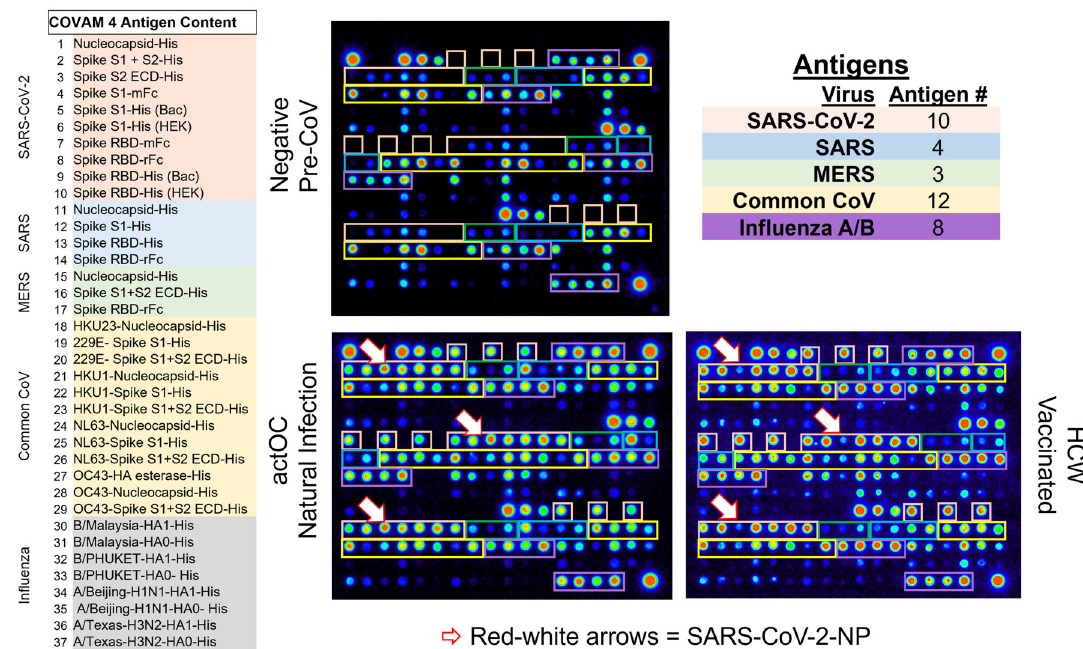
Fig. 1 Coronavirus antigen microarray — COVAM. The content of the coronavirus antigen microarray is shown. There are 10 SARS-CoV-2 antigens, 3 SARS, 3 MERS, 12 Common COV, and 8 in fl uenza antigens. Each antigen is printed in triplicate and organized as shown on the images with Orange boxes around the SARS-CoV-2 antigens, Blue SARS, Green MERS, Yellow Common CoV, and Purple for In fl uenza. Three different samples are shown, a negative Pre-CoV, natural infection (actOC), and a sample from an mRNA vaccinee (HCW). The Pre-CoV sample has negligible reactivities to SARS-CoV-2, SARS, and MERS, whereas natural infection and the vaccinees have signi fi cant antibodies against the novel CoV. The red-white arrows point to the nucleocapsid protein which detects antibodies in naturally exposed people but not in the vaccinees.